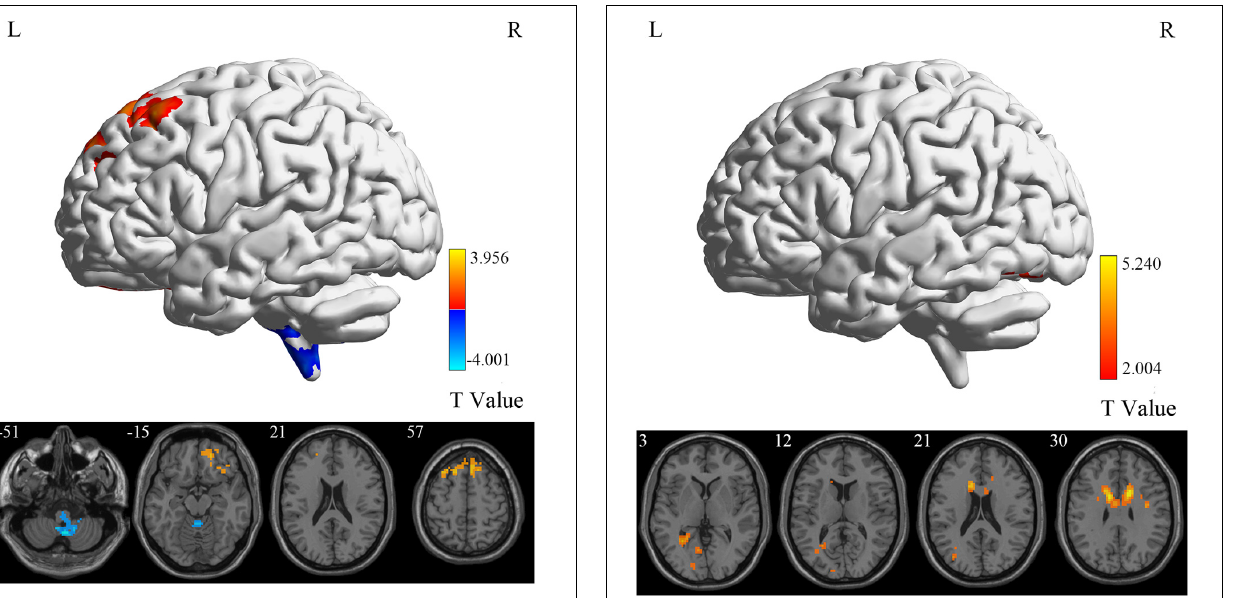
FIGURE 5 | ReHo differences between MCI reverters and HCs. ReHo, regional homogeneity; HCs, healthy controls; L, left; MCI, mild cognitive impairment; R, right.